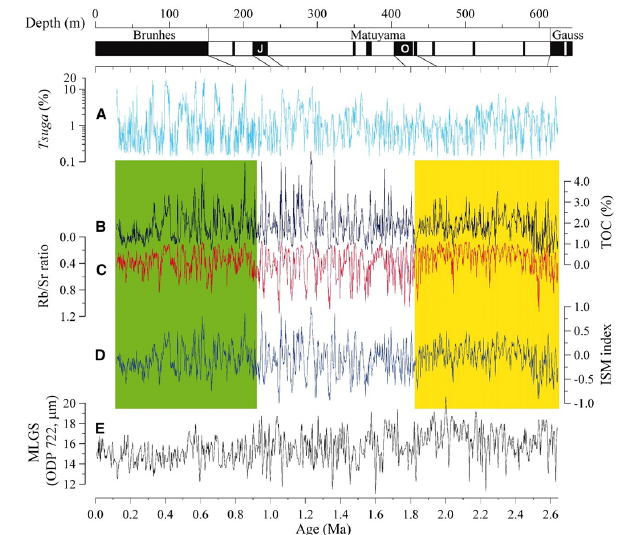
Figure 9. Comparison of Lake Qinghai records with other records during the last 32kyr (An et al., 2012). (a) NGRIP δ 18 O 26 ; (b) North Atlantic ice-rafted hematite stained grains; (c) Lake Qinghai Westerlies climate index (WI, flux of >25µm fraction); (d) Lake Qinghai Asian summer monsoon index (SMI); (e) δ 18 O record of ostracods from Lake Qinghai; (f) Dongge cave speleothem δ 18 O 21 ; (g) atmosphere (cid:49) 14 C 38